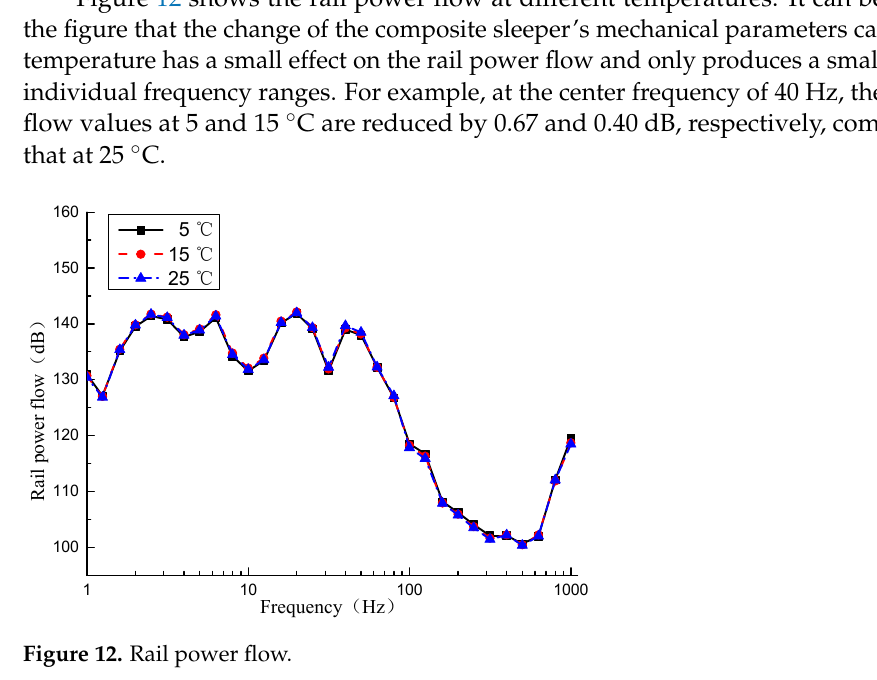
Figure 11. Ballast bed power flow.